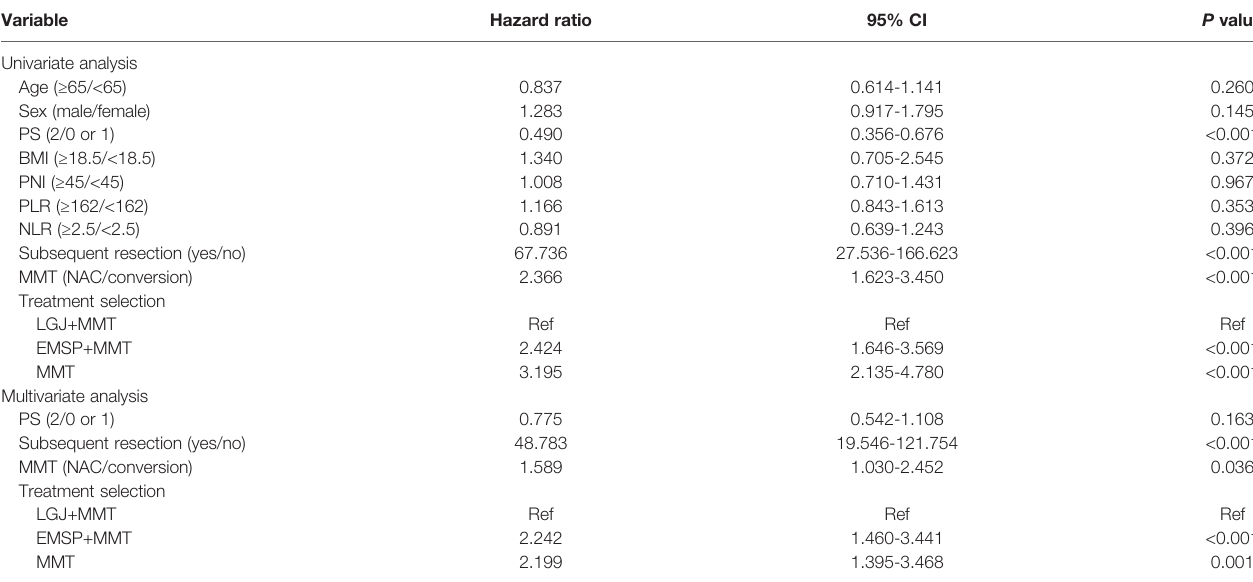
TABLE 4 | Univariate and multivariate analyses for